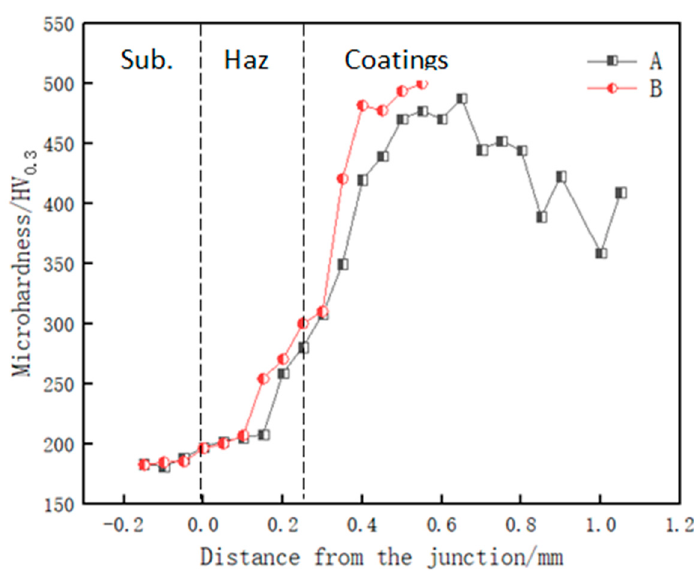
Figure 9. Microhardness distribution of cladding layers of Samples A and B.